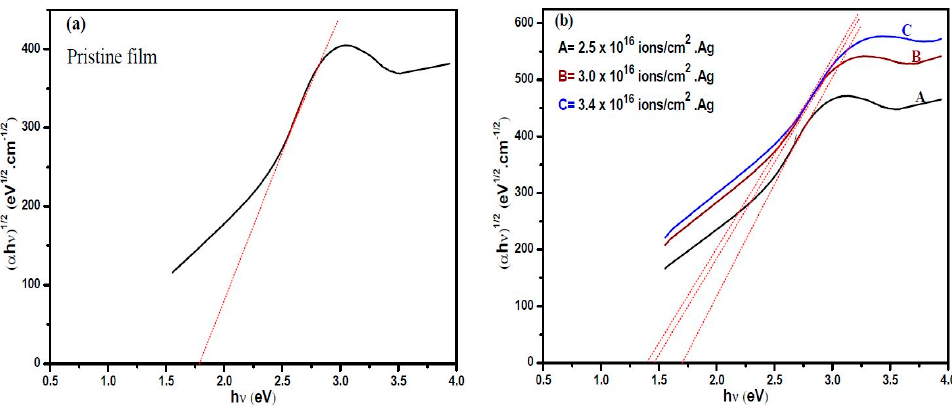
Figure 6. Tauc plots for ( a ) pristine and ( b ) combined Ag:a-C nanocomposites showing respective optical bang gap energies.